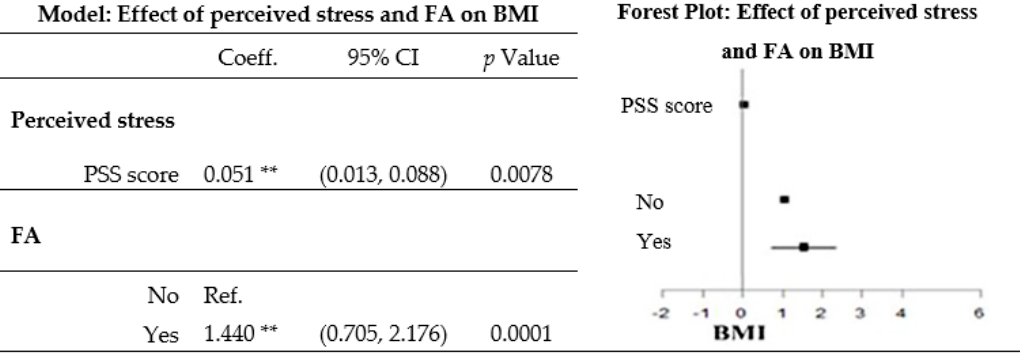
Figure 3. Effect of perceived stress and food addiction (FA) on the body mass index (BMI) after adjusting for sociodemographic variables. The model was obtained from a multiple linear regression, and was adjusted for sex, age group, employment status, and educational attainment. ** 0.0001 ≤ p - value ≤ 0.01. PSS, Perceived Stress Scale; Coeff., coefficient; Ref., reference.